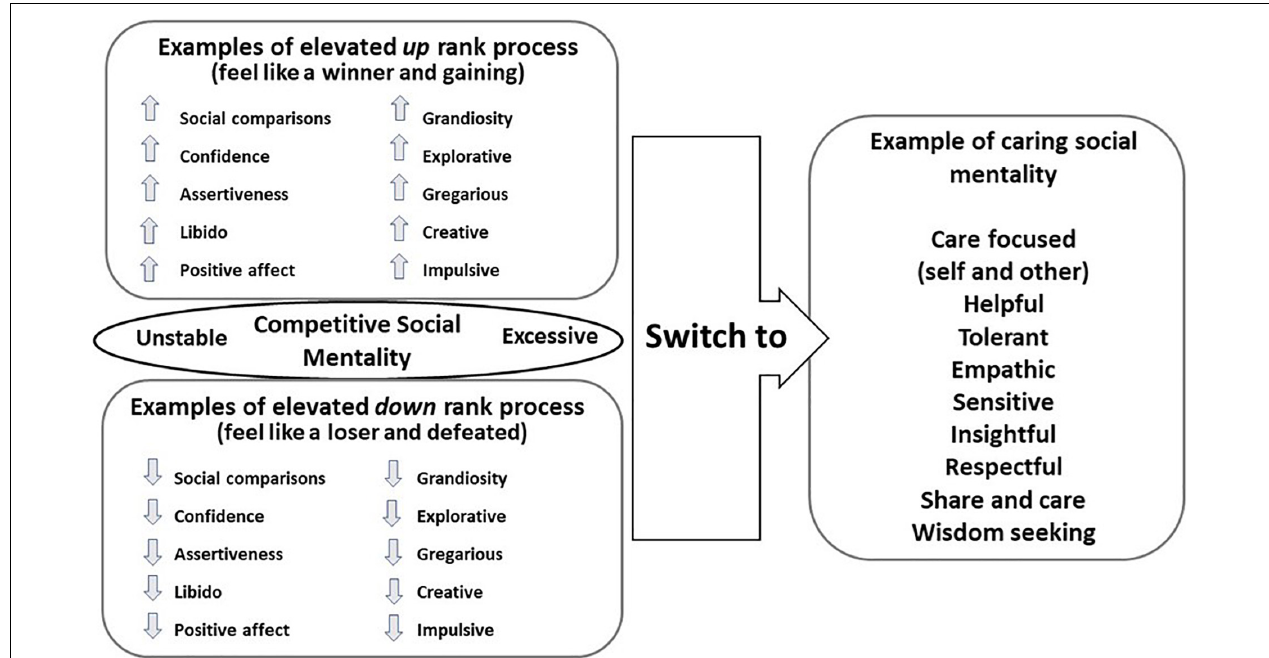
FIGURE 2 | An overview of the instability of the process underpinning social ranking and the movement towards caring motivational process. ©Paul Gilbert.